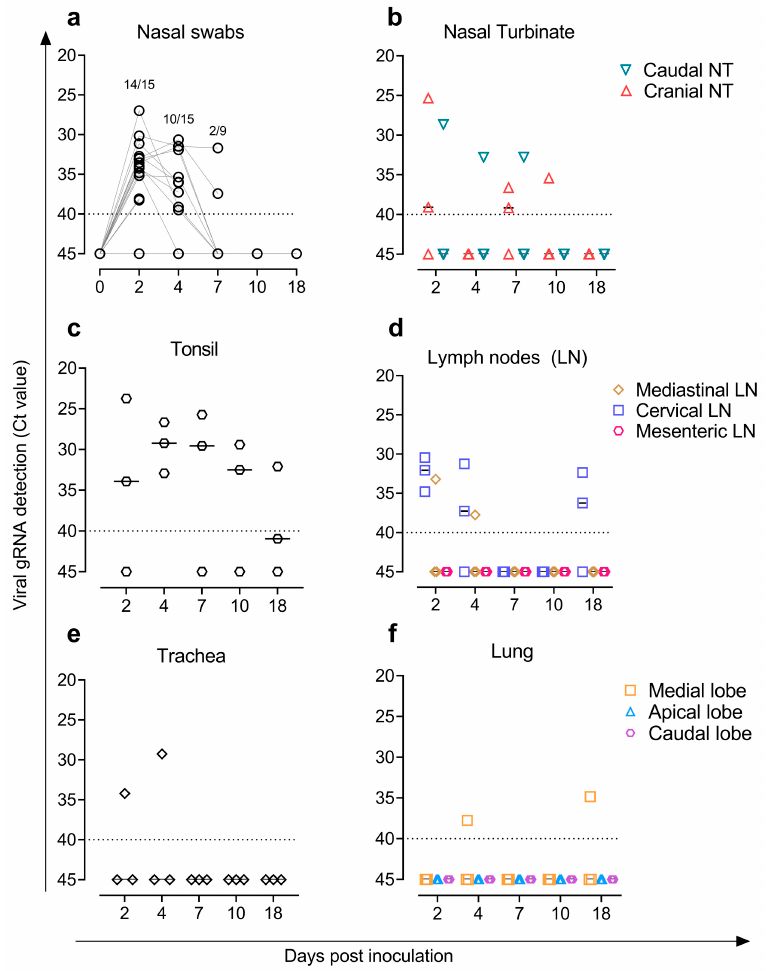
Figure 3. Detection of SARS-CoV-2 genomic RNA (gRNA) by RT-qPCR. SARS-CoV-2 loads in ( a ) nasal swabs; ( b ) cranial and caudal nasal turbinate; ( c ) tonsil; ( d ) mediastinal, cervical, and mesenteric lymph nodes; ( e ) trachea; and ( f ) lung. Horizontal bars indicate median viral loads. Dotted lines reflect the limit of detection (Ct = 40).